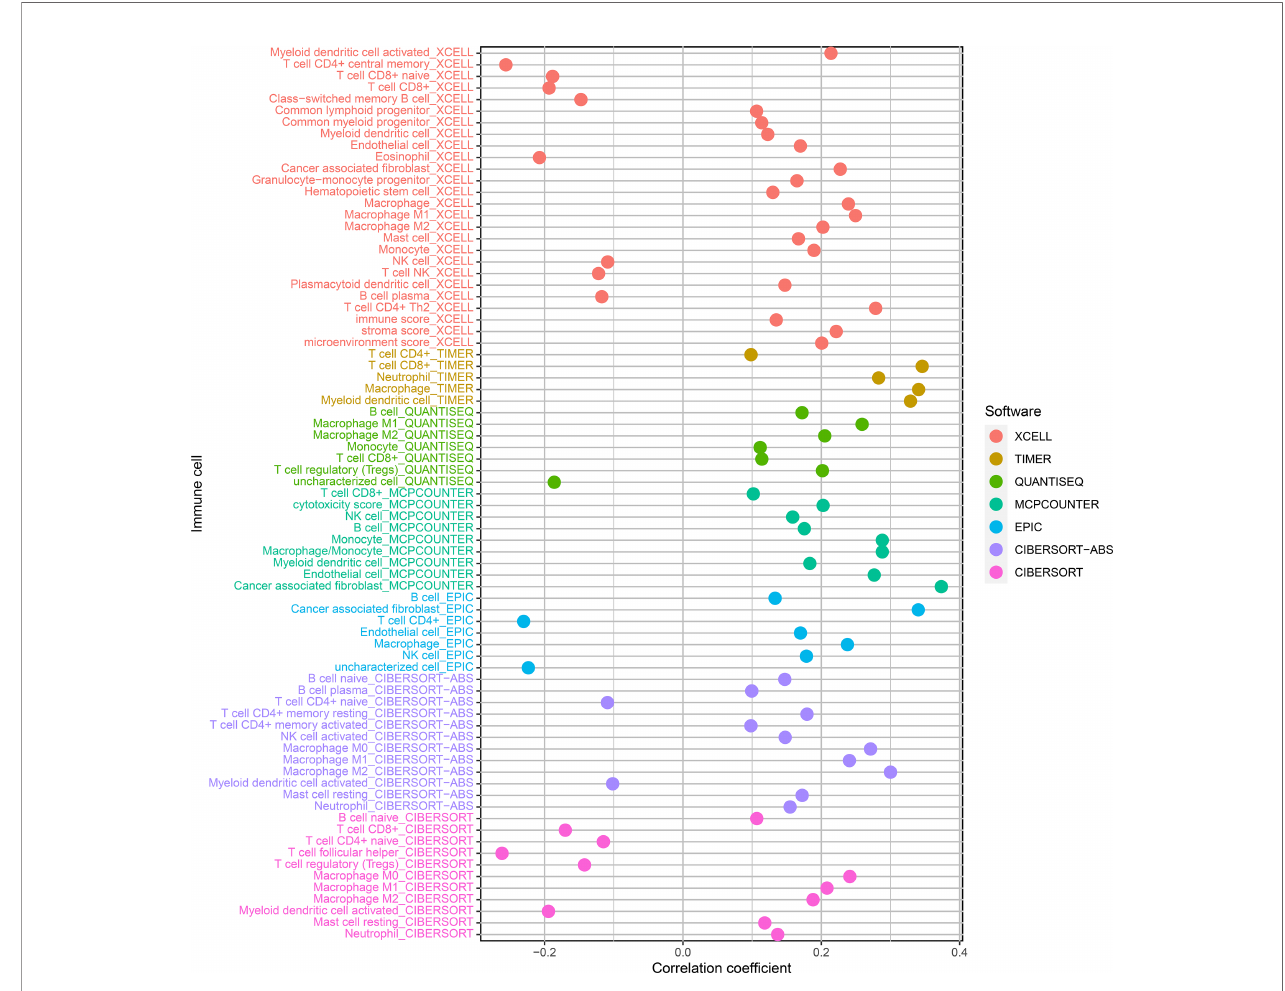
FIGURE 7 | Correlation analysis of tumor-in fi ltrating immune cells and risk models of patients with